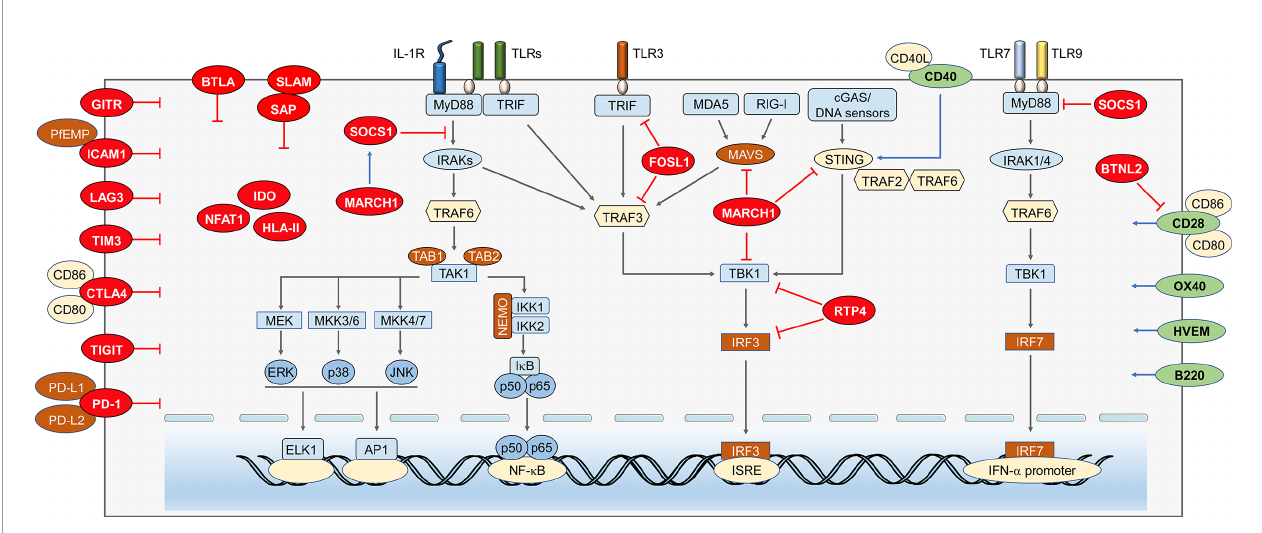
FIGURE 2 | Immune regulators in anti-malaria immunity. Anti-malaria immunity is tightly regulated by cytosolic and cell surface molecules at multiple levels. Negative regulators within cytosol. As a negative molecule binds to MyD88, SOCS-1 can not only suppress the NF- k B and MAPKs signaling, but also inhibits MyD88- mediated IFN-I signaling. MARCH1 can reduce IFN-I through increasing expression of SOCS-1. Besides, its target proteins, MAVS, STING, and TBK1, possibly are degraded through ubiquitination. FOSL1 inhibits the K63 ubiquitination of TRAF3 and TRIF and disrupts TBK1/TRAF3/TRIF complexes formation, which results in reduced phosphorylation of IRF3 and suppresses IFN-I production. RTP4 inhibits the expression of TBK1 and IRF3 and/or activation by binding with TBK1 to reduce IFN-I production. Negative regulators on the cell membrane . Binding of ICAM1 and PfEMP leads to static adhesion of parasite and evades immune clearance. LAG3 inhibits T cell responses and antibody secreting B cell responses. CTLA-4 expressed on activated T cells could suppress the CD4 + Th and humoral immune responses. TIM3 can inhibit T lymphocytes, NK cells, and macrophages responses. TIGIT proteins mainly suppress the function of T cell and NK cell. The activation of PD-1 pathway dramatically inhibits TCR-mediated proliferation and function of T cells. Positive regulators on the cell membrane. CD40 could compete with STING to bind TRAF2/3 and/or TRAF6 to reduce STING ubiquitination, which leads to increased expression of IFN-I. CD28 can enhance CD4 + T cell responses, but the CD28-B7 signals can also be inhibited by BTNL2. OX40 enhances Plasmodium speci fi c CD4 T cell activity. B220 expressed on the surface of B and T cells can help promoting the maturation of both T and B